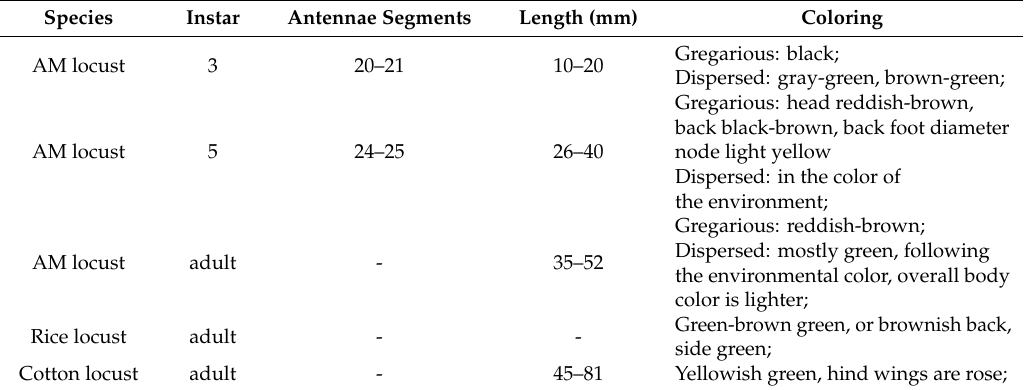
Table 2. Analysis of the phenotypic characteristics of East Asian migratory (AM) locusts, rice locusts, and cotton